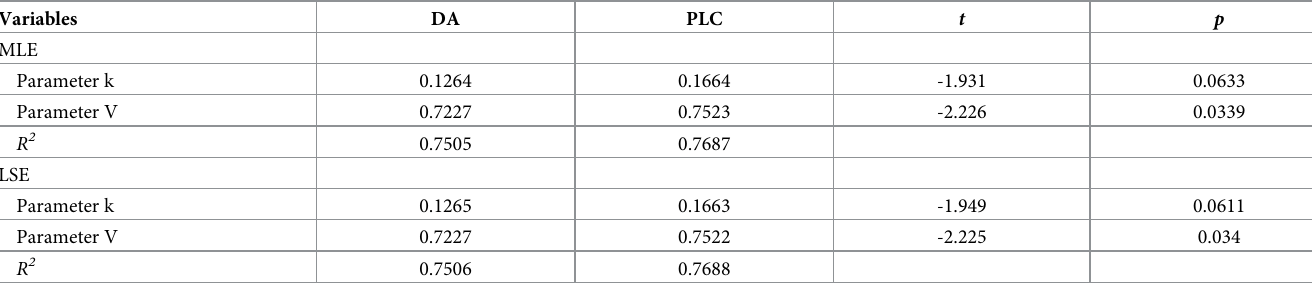
Table 1. Results of robustness